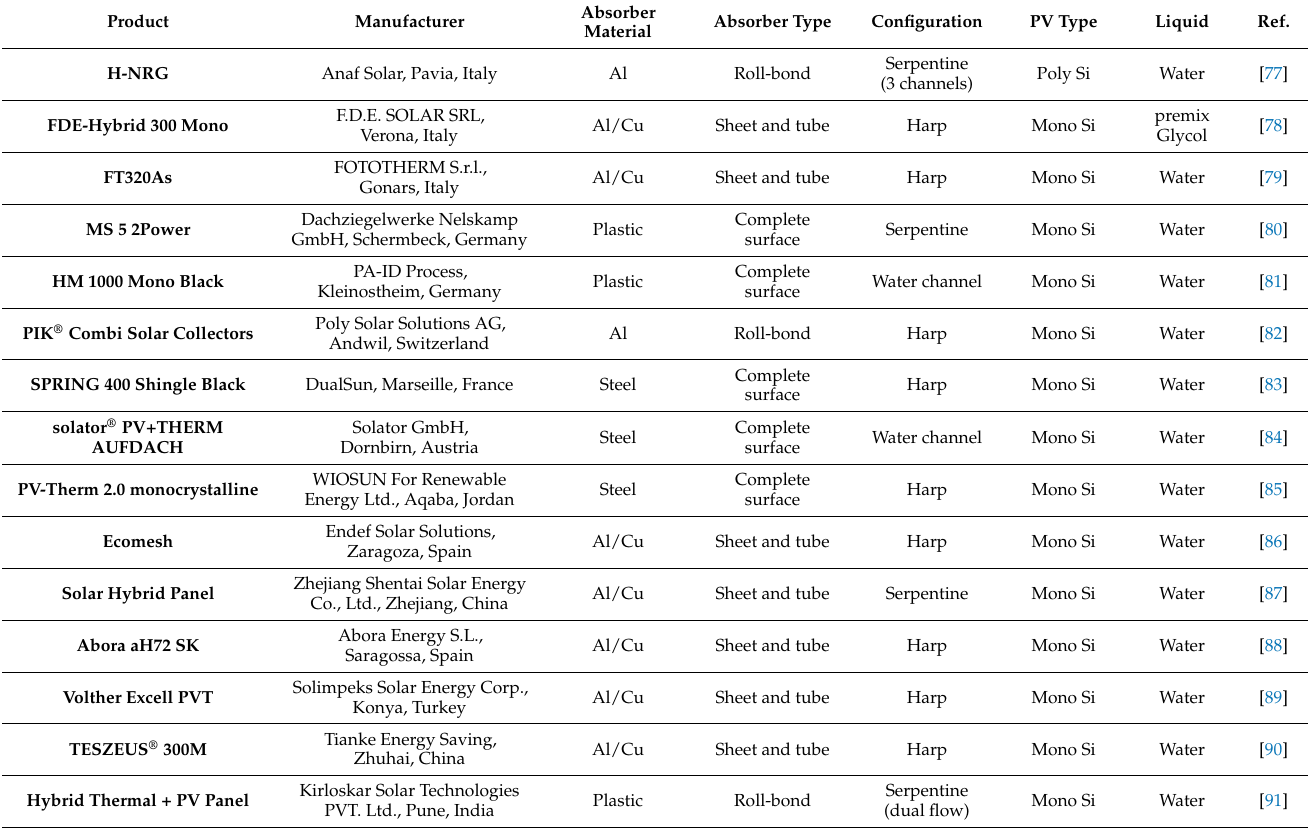
Table 2. Various PVT products are available in the